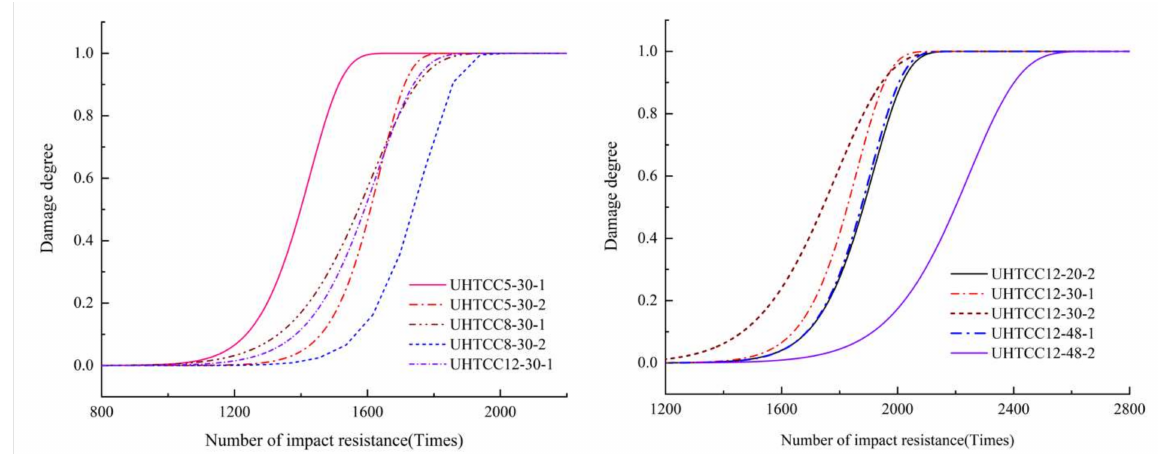
Figure 10. UHTCC impact damage